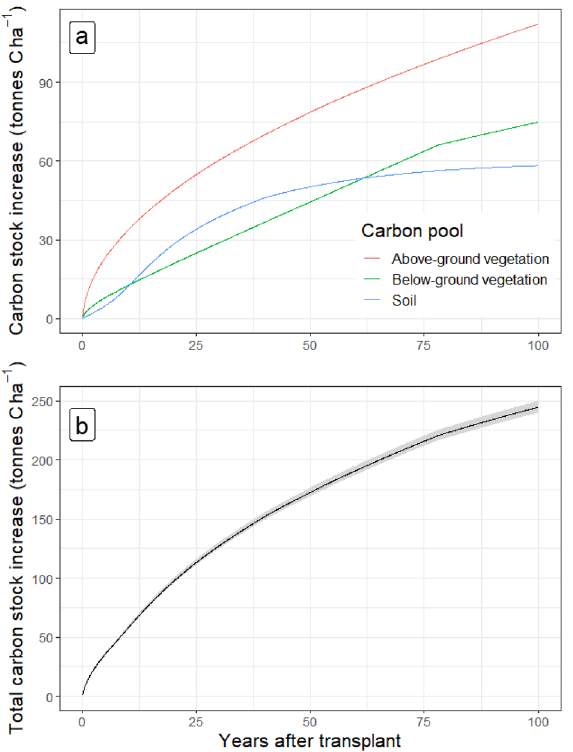
Figure 5. Changes in carbon stocks following transplanting. ( a ) Vegetation and soil. ( b ) Total, with ± 1 SD indicated by the